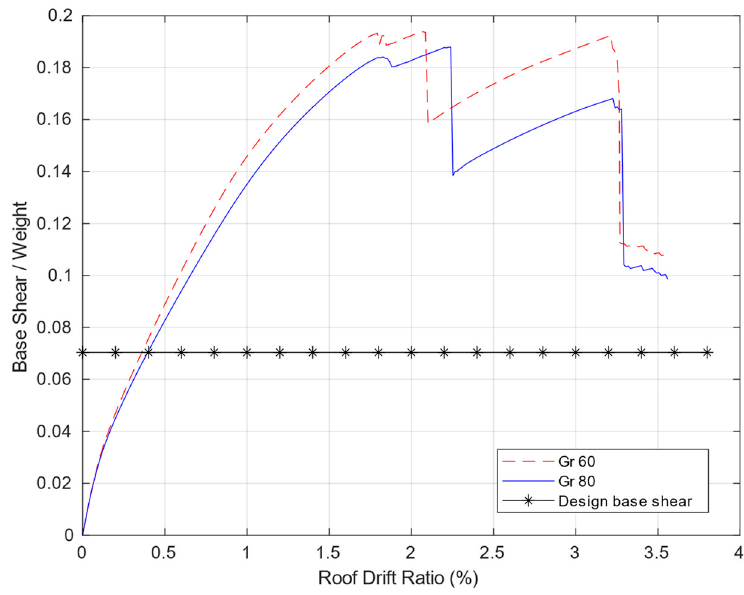
Figure 5. Pushover curves for the analyzed buildings.